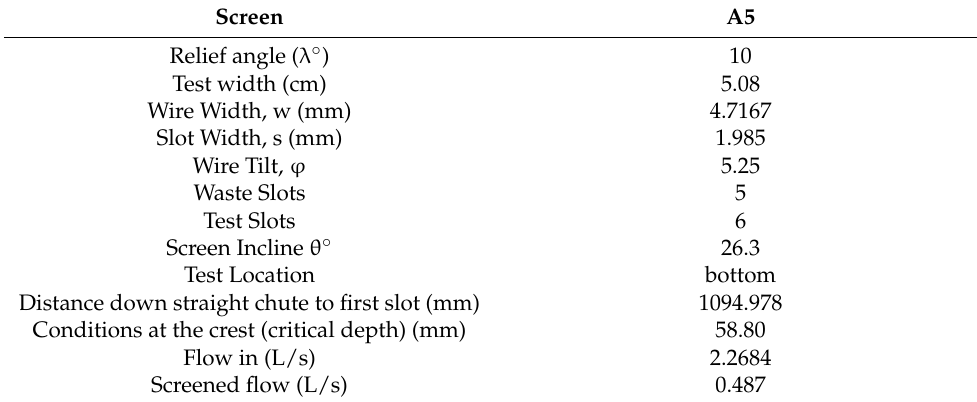
Table 5. Validation Screen